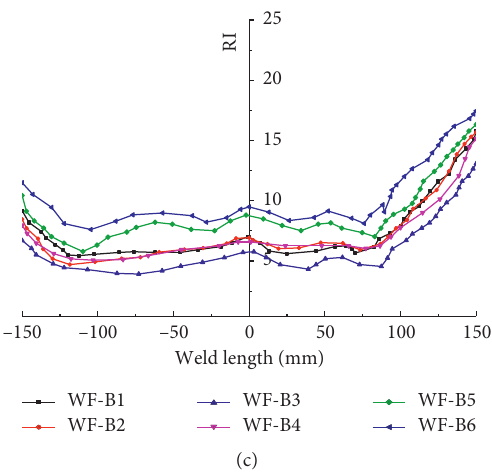
Figure 10: WF-B. (a) Triaxiality ratio. (b) Equivalent plastic strain index. (c) Cracking index.